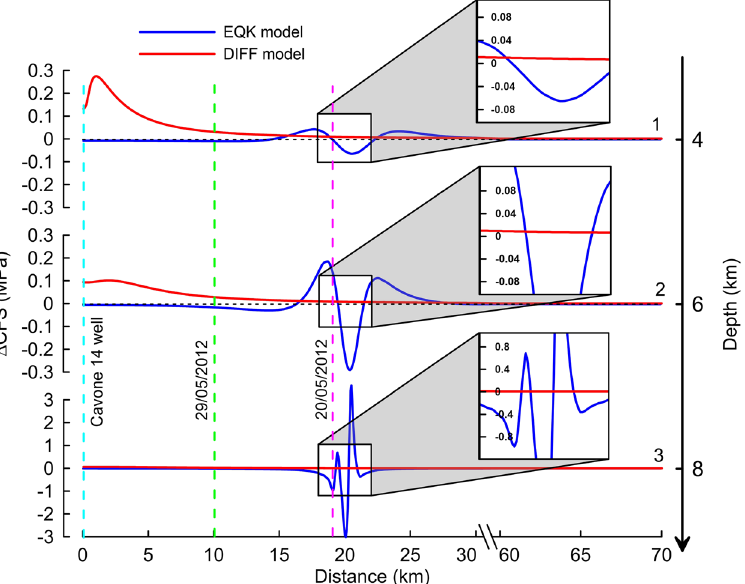
Figure 4. Δ CFS comparison between the DIFF and EQK models along horizontal sections 1, 2, and 3 in Fig. 2a. This figure was created with Grapher ® from Golden Software, LLC